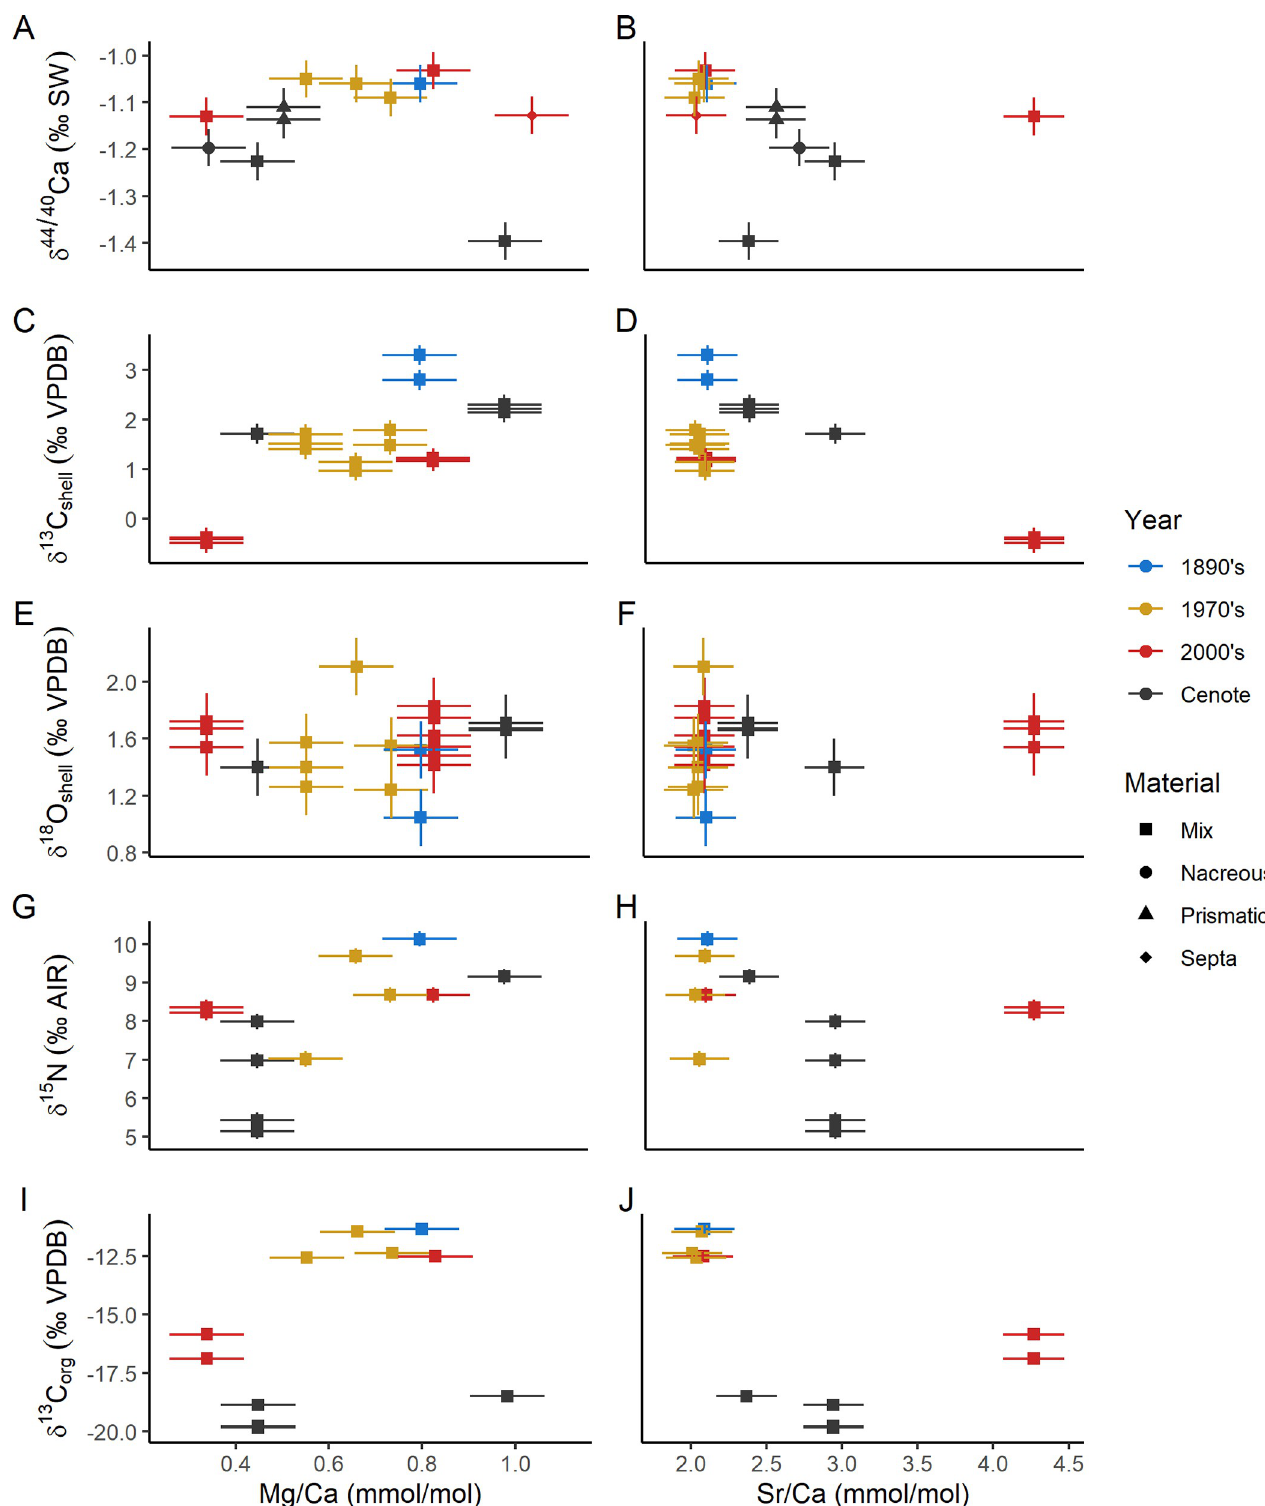
Fig 4. Crossplots of Sr/Ca and Mg/Ca ratios vs isotope values measured on shell carbonate. Error bars are 2 standard deviation instrumental precision for isotope values and the 5% RSD propagated to the elemental ratios. A) δ 44/40 Ca vs Mg/Ca, B) δ 44/40 Ca vs Sr/Ca, C) δ 13 C shell vs Mg/Ca, D) δ 13 C shell vs Sr/Ca, E) δ 18 O shell vs Mg/Ca, F) δ 18 O shell vs Mg/Ca, G) δ 15 N vs Mg/Ca, H) δ 15 N vs Sr/Ca, I) δ 13 C org vs Mg/Ca, and J) δ 13 C org vs Sr/Ca. The cenote and historical samples distinctly differ along Mg/Ca, Sr/Ca, δ 15 N, δ 13 C org , and δ 44/40 Ca axes. https://doi.org/10.1371/journal.pone.0277666.g004 PLOS ONE | https://doi.org/10.1371/journal.pone.0277666 December28,